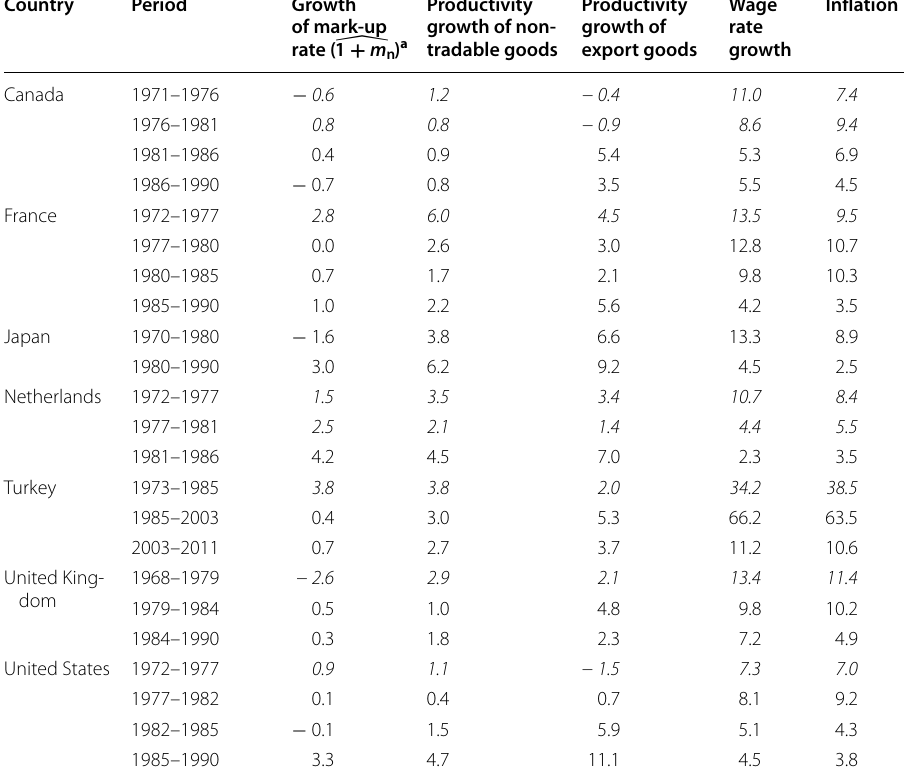
Table 1 Domestic consumption growth and export growth by country (annual rate, unit: %). Source : Author’s calculations. The OECD tables aggregated to nine main industries were used to calculate productivity growth. Inflation rates for the Netherlands and the United Kingdom were derived from OECD (consumer price), and those of other countries were derived from the World Bank (inflation, consumer price). Wage growth was derived from the OECD tables, and employment was derived from the ILO (Wage rate growth was proportional in both non-tradable goods and export goods, and imported material costs were negligible. However, countries did not have constant mark-up rate growth. For addi- tional information, see Ünal (2016a). For Turkey, 1973 and 1985 were derived from Turk- Stat and WIOD tables were used to calculate productivity growth between 2003 and